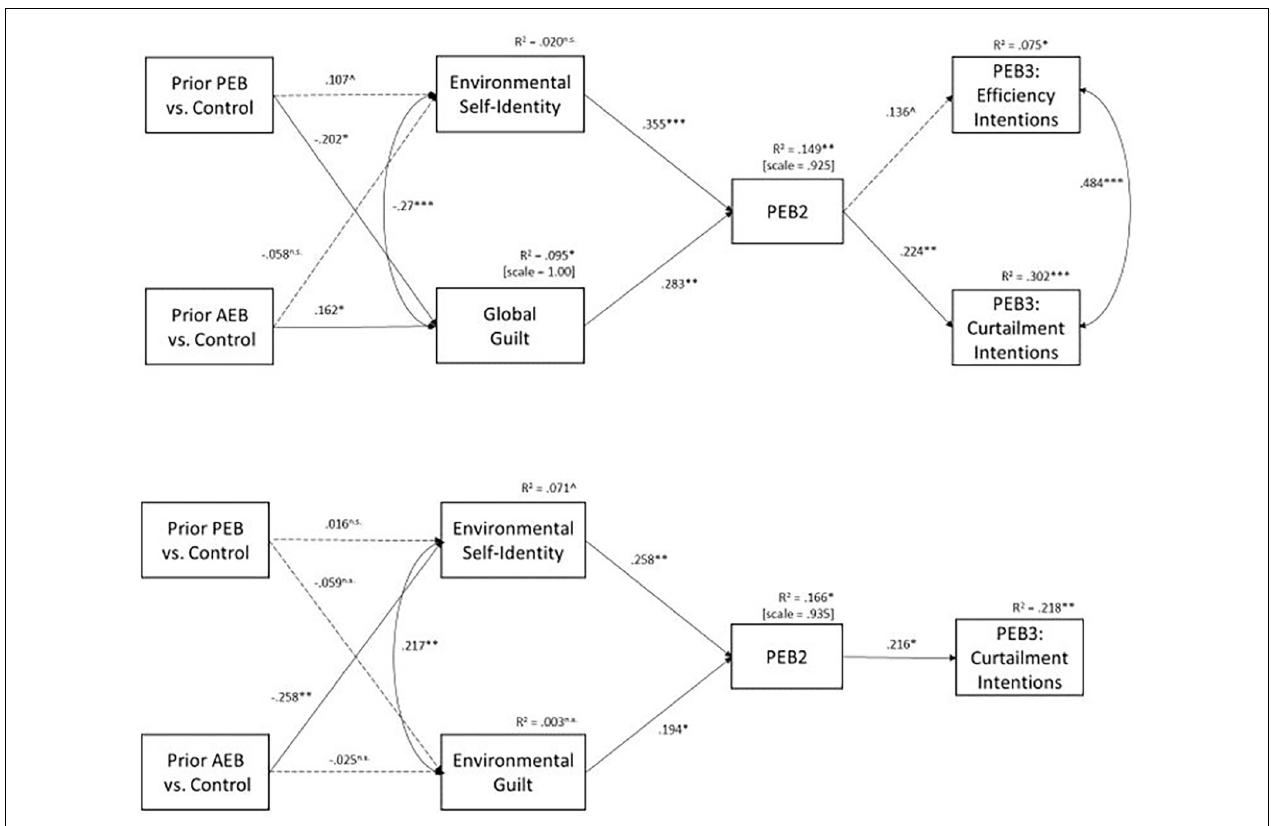
FIGURE 2 | Results of direct effects in model testing spillover from prior behavior reminders to PEB2 performance, Study 1 (top panel) and Study 2 (bottom panel). PEB, pro-environmental behavior. Dashed lines represent paths with p > 0.05. n.s., non-significant. Only major theorized direct paths are shown in figure, though all indirect and direct paths are modeled. *** p < 0.001; ** p < 0.01; * p < 0.05; ˆ p <